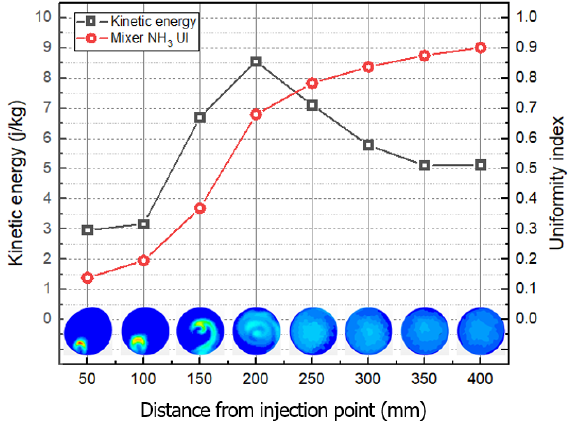
Figure 11. Kinetic energy and ammonia UI over the distance from a urea injection point.